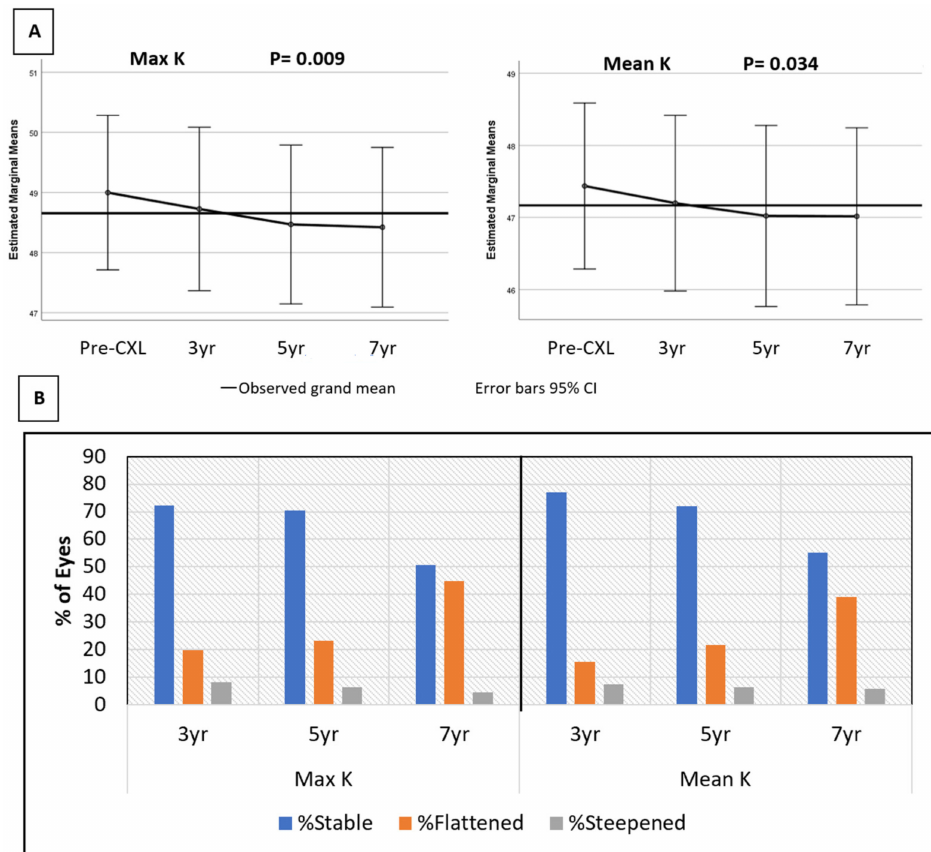
Figure 2. ( A , B ) Change in maximum and mean keratometry from the pre-crosslinking (CXL) value. ( B ): Percentage of eyes with stable (within 1 D), flattened (< − 1 D), and steepened (>1 D) keratometry values over